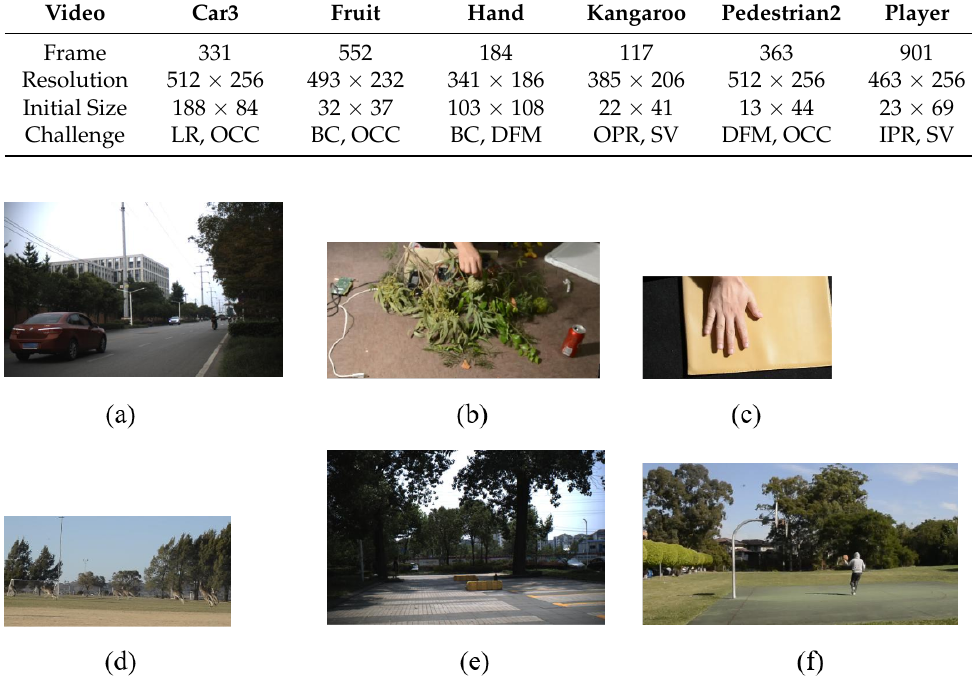
Figure 7. RGB videos for six experiments. ( a ) Car3; ( b ) Fruit; ( c ) Hand; ( d ) Kangaroo; ( e ) Pedestrian2; ( f )